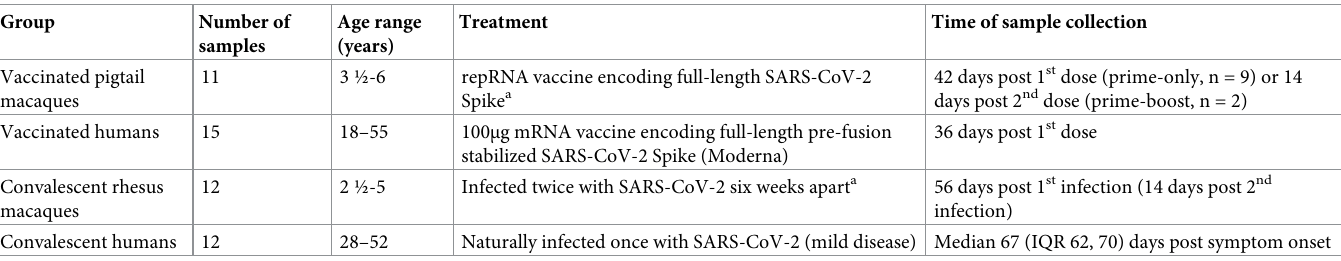
Table 1. Details of samples used in the current